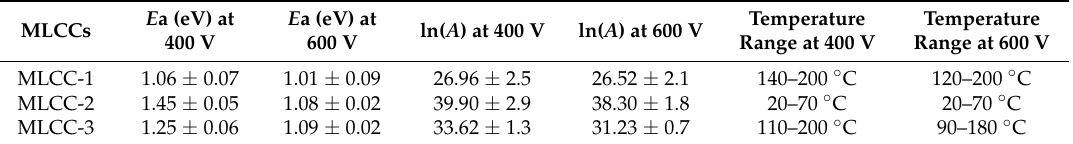
Table 3. Activation energy values obtained from the Arrhenius model for MLCCs tested under two different voltages and a range of temperatures (Figure 11).